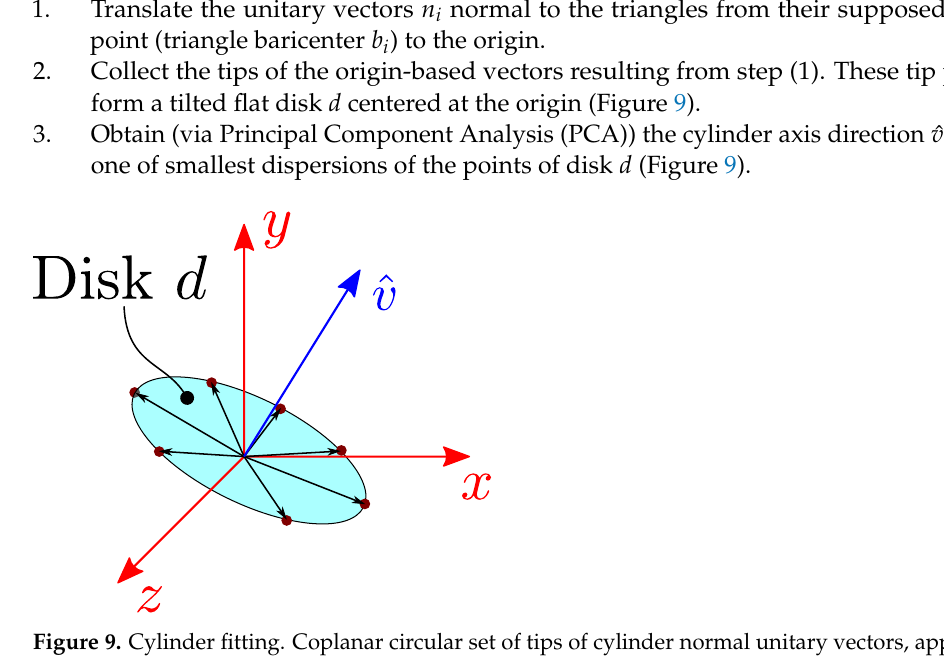
Figure 9. Cylinder fitting. Coplanar circular set of tips of cylinder normal unitary vectors, applied at origin. ˆ v : direction of minimal dispersion of disk d , cylinder axis